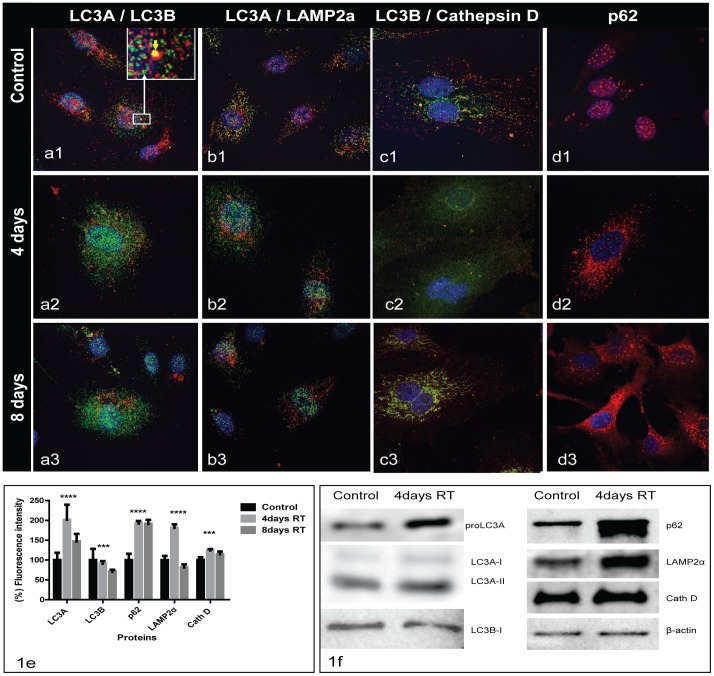
HUVEC confocal immunofluorescent microscopy images LC3A(green)/LC3B(red) (Fig. 1a), LC3A(green)/LAMP2a(red) (Fig. 1b), LC3B(red)/CathepsinD(green) (Fig. 1c) and p62(red) (Fig. 1d).Co-localization is presented as yellow spots. Figure 1a: autophagosomes stained for LC3A (perinuclear localization) and LC3B (cytoplasmic localization). Irradiation-induced accumulation of both LC3A and LC3B autophagosomes at 4 and 8 post-irradiation days (1a2,1a3). Figures 1b1 and 1c1 show an evident degree of co-localization of LC3A with LAMP2a and of LC3B with CathepsinD. At 4 and 8 post-irradiation days there was a lack of co-localization, which suggests autophagy flux suppression (1b2, 1b3, 1c2, 1c3). Figure 1d shows poor cytoplasmic and intense nuclear presence of p62 in control cells (1d1); intense accumulation of p62 in the cytoplasm was evident 4 and 8 days after irradiation (1d2,3). Graphic presentation of fluorescent intensity of the above immunostaining is shown in Figure 1e. Figure 1f shows the western blot analysis in the pellet fraction of HUVEC.